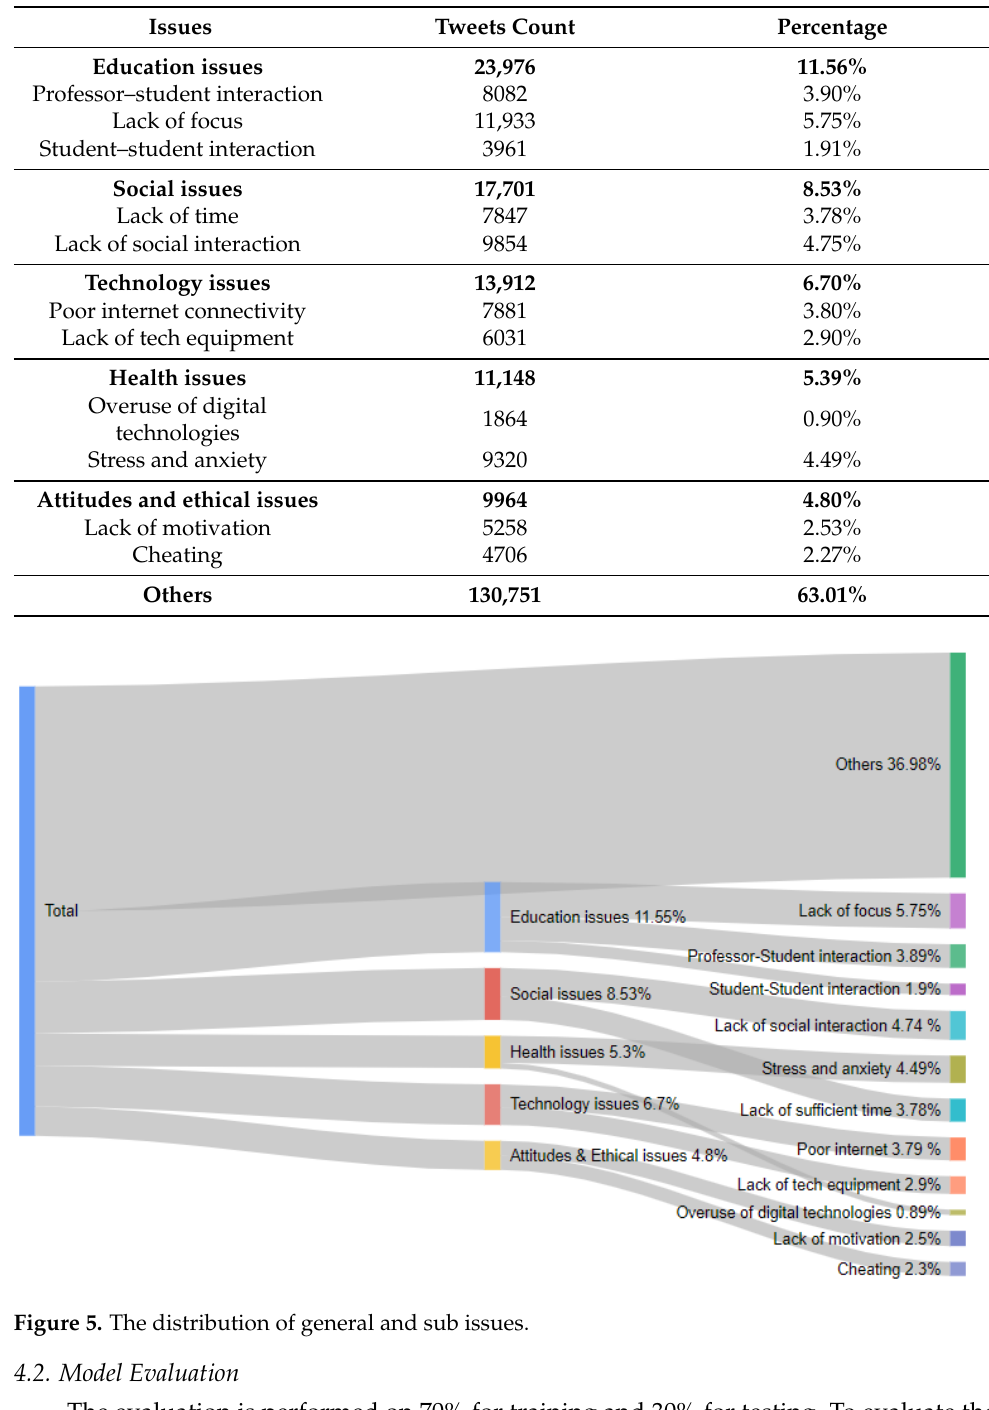
Table 4. The counts and percentages of general and sub issues.